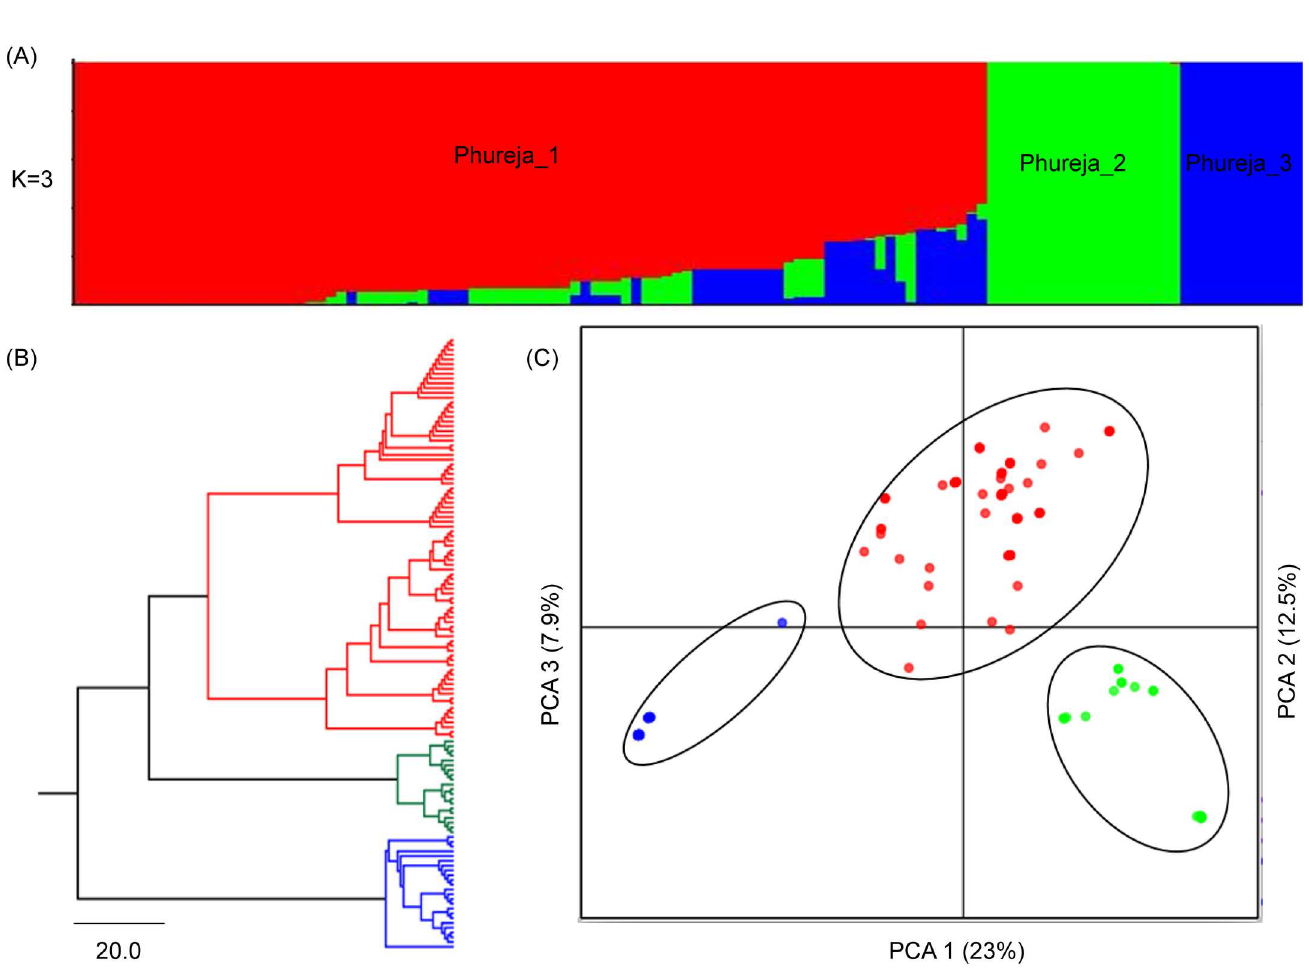
Fig 3. Population structure of 133 diploid accessions (Phureja population) of Colombian Central Collection of S . tuberosum . (A) Clustering Structure analysis. (B) NJ-tree basedon Nei´s geneticdistances. (C) DiscriminantAnalysis PrincipalComponent.